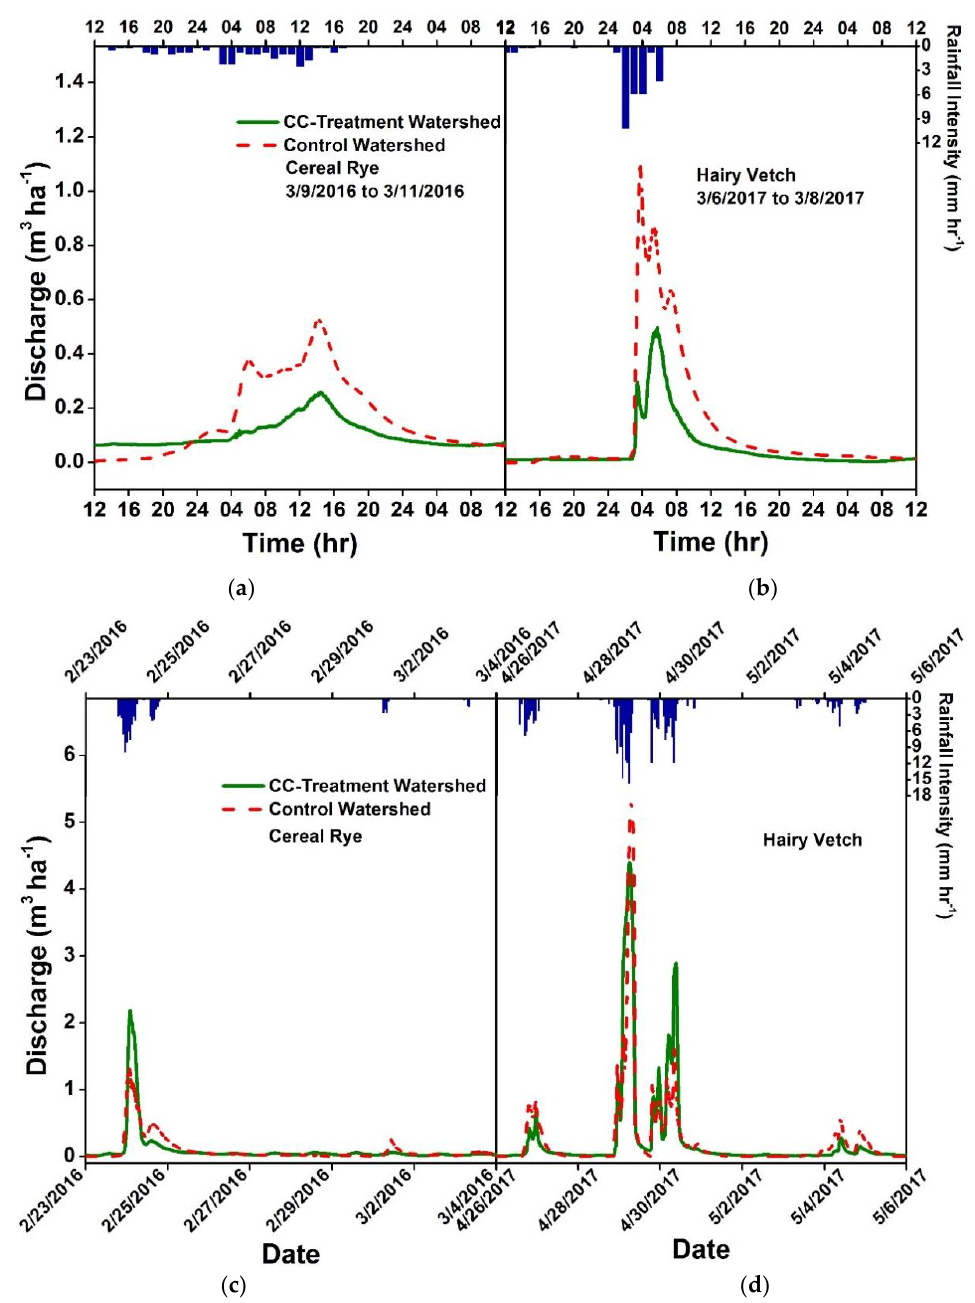
Figure 5. Storm water discharge measured from paired watersheds representing storm events received during cover crop season in 2016 and 2017 with rainfall intensity lower than 10 mm hr −1 ( a , b ) and greater than 10 mm hr −1 ( c , d ). Blue bars represent rainfall intensity (mm hr −1 ). 3.3. Observed-Predicted Discharge: TSS, NO 3 -N, NH 4 -N, and DRP for CC-Treatment Watershed